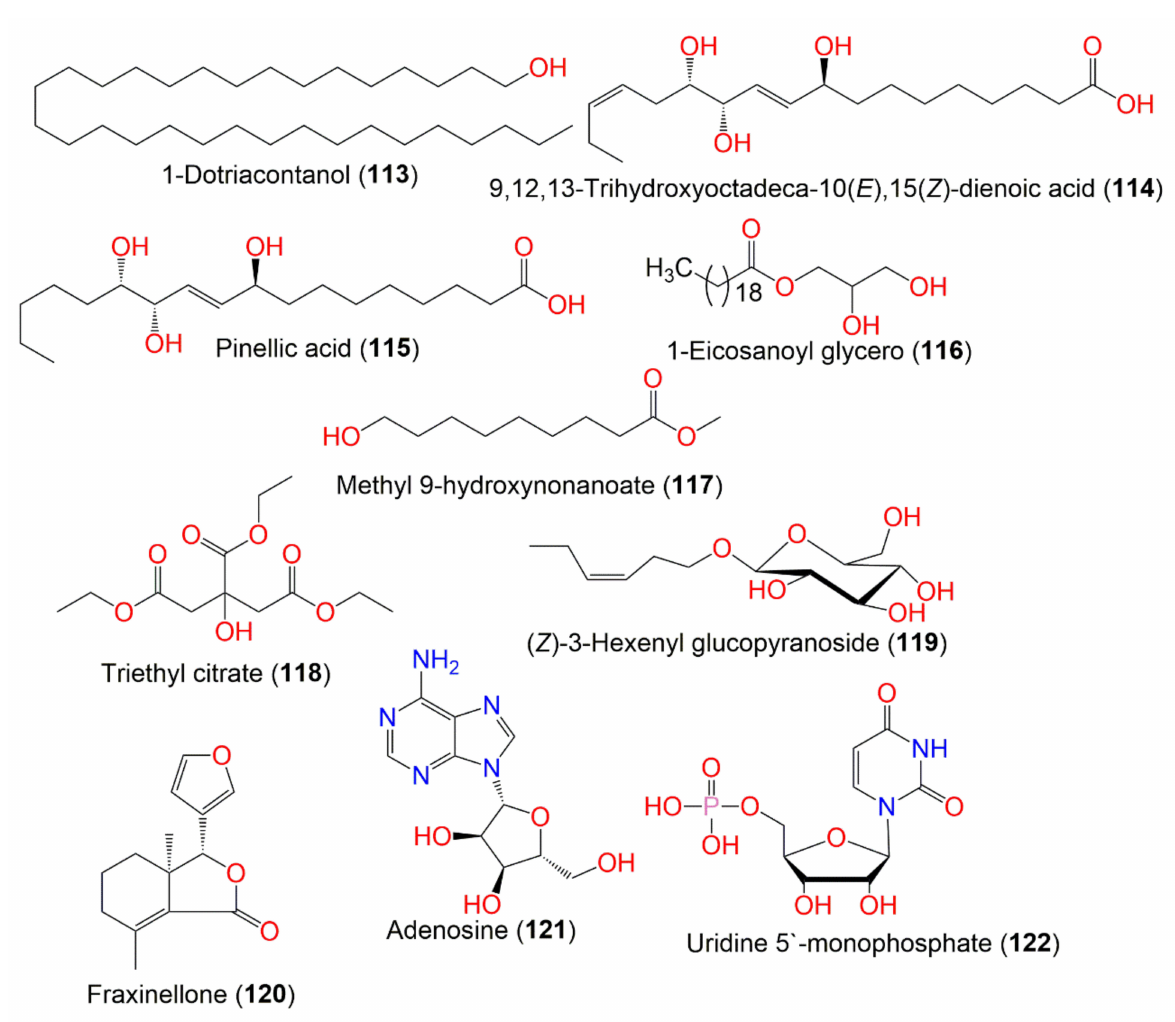
Figure 13. Structures of compounds 113 – 122